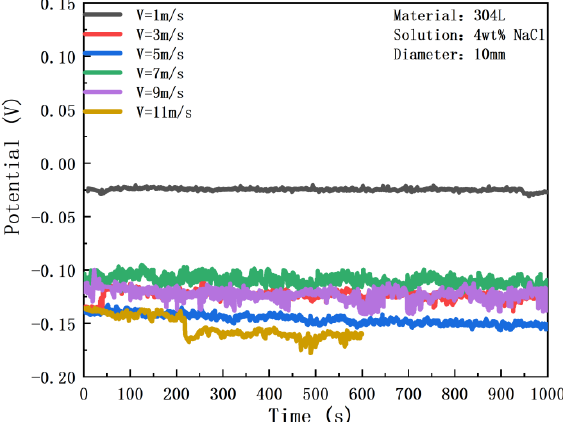
Figure 4. Open-circuit potential of specimens at different flow velocities.